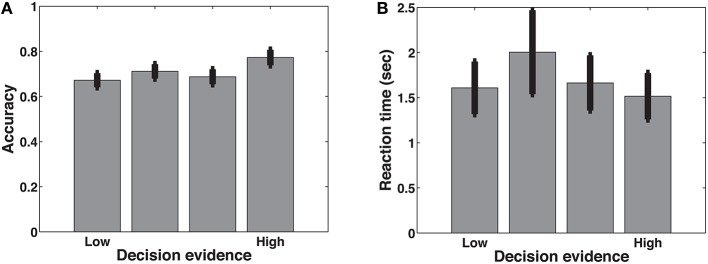
Mean accuracy (A) and reaction times (B) separated by decision evidence as indexed by summed similarity. Error bars represent the standard error of the mean.